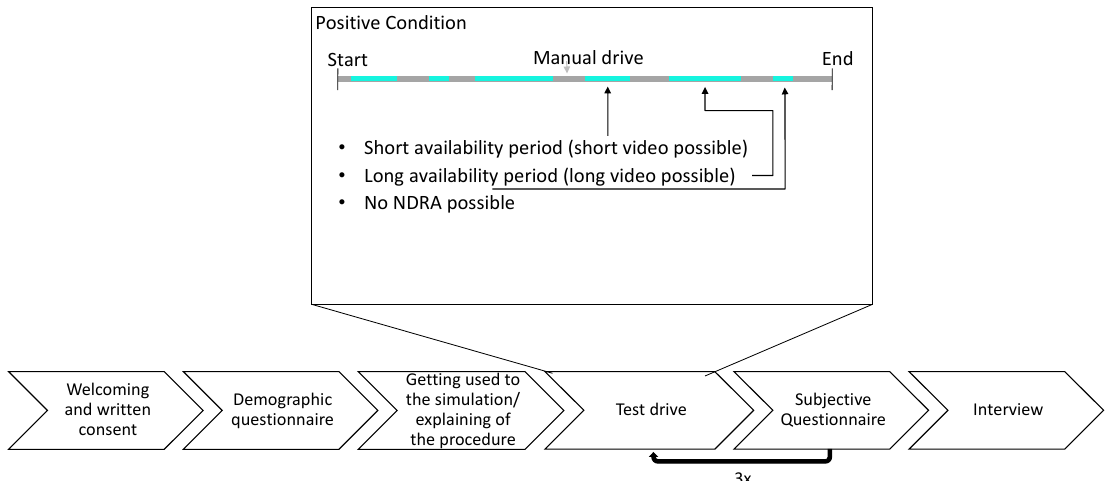
Figure 3. Procedure of the study with an exemplary test drive. Periods without available automation are grey; periods with available automation are blue.